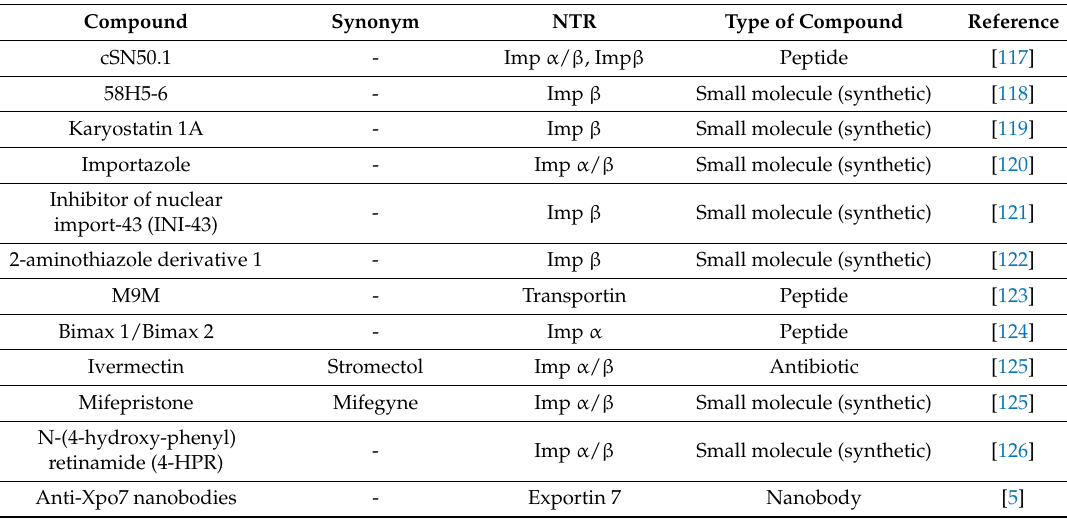
Table 3. Selected protein nuclear import